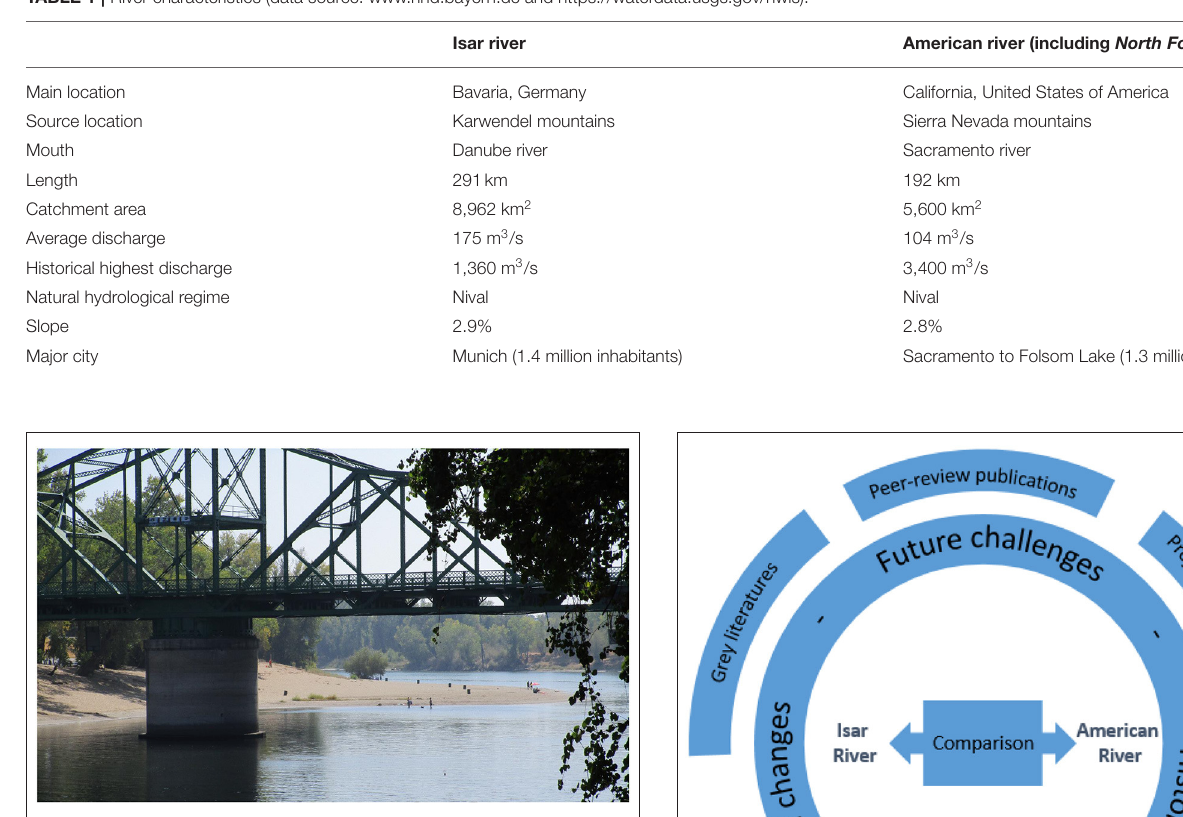
TABLE 1 | River characteristics (data source: www.hnd.bayern.de and https://waterdata.usgs.gov/nwis).